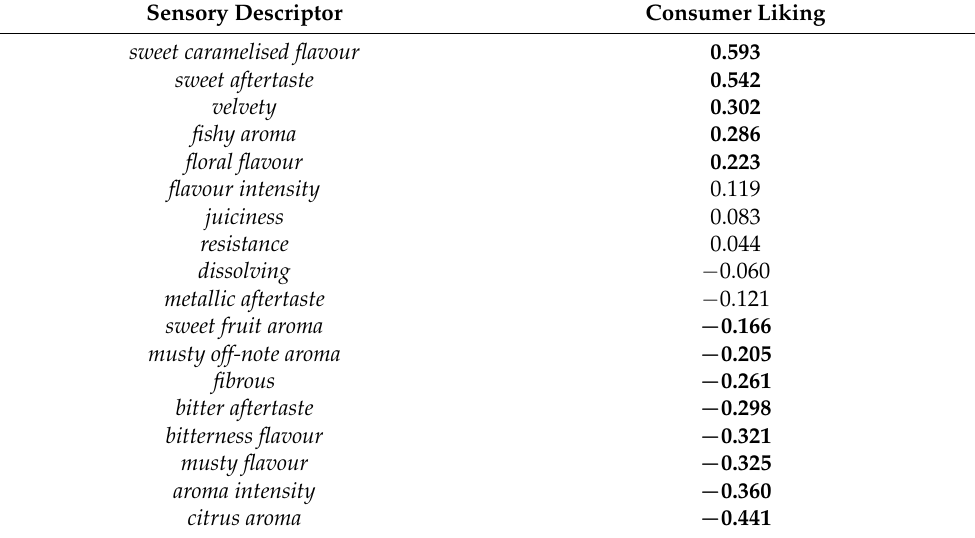
Table 3. Correlation between consumer-liking score and sensory descriptors.